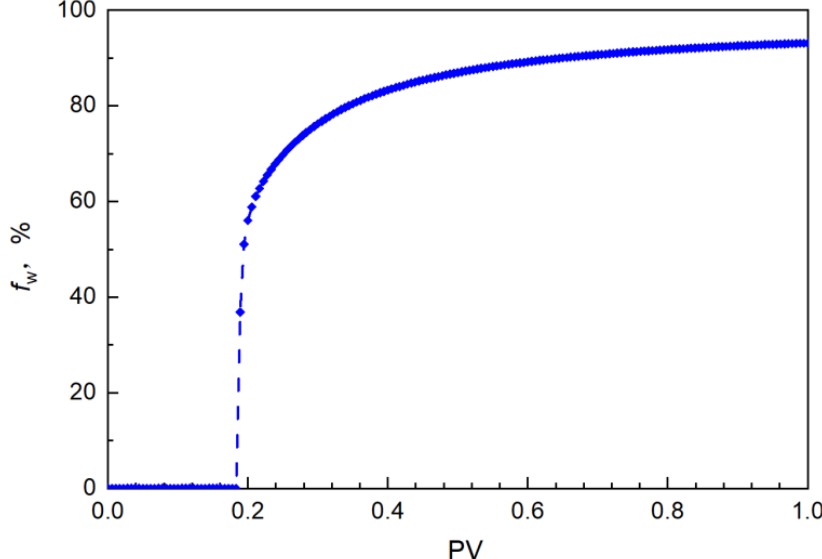
Figure 11. Water saturation distribution along the flow during water flooding. When the displacement time was 0.10 PV, the position of the water displacement front reached a dimensionless distance of 0.57. When the displacement time was 0.20 PV, the water saturation along the flow was higher than that of the displacement front (30%), indicating that the water phase reached the outlet end, completing the breakthrough. outlet end was approximately 0.18 PV, the water cut at the outlet end increased rapidly.